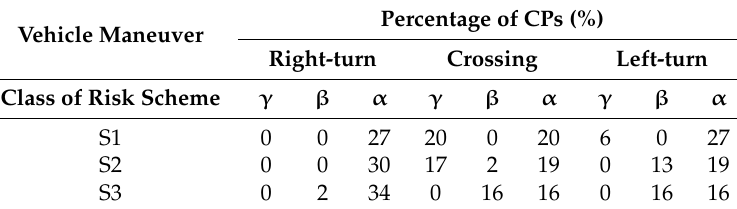
Table 6. Analysis of the conflict points at S1, S2, and